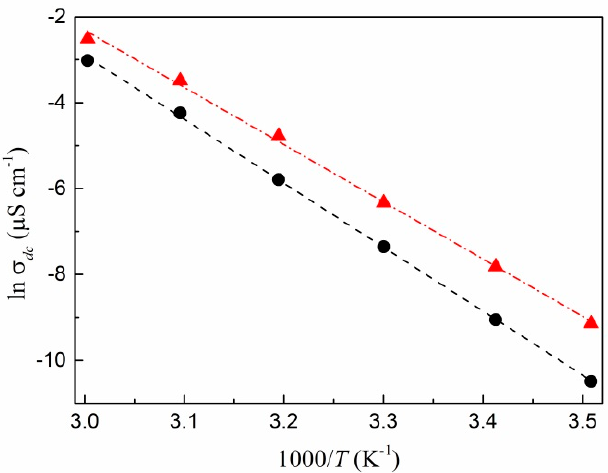
Figure 8. DC conductivity logarithm versus 1/ T for Ag/PAN nanocomposite films, prepared at 20 ( ● ) and 30 ( ▲ ) wt.% AgNO 3 .